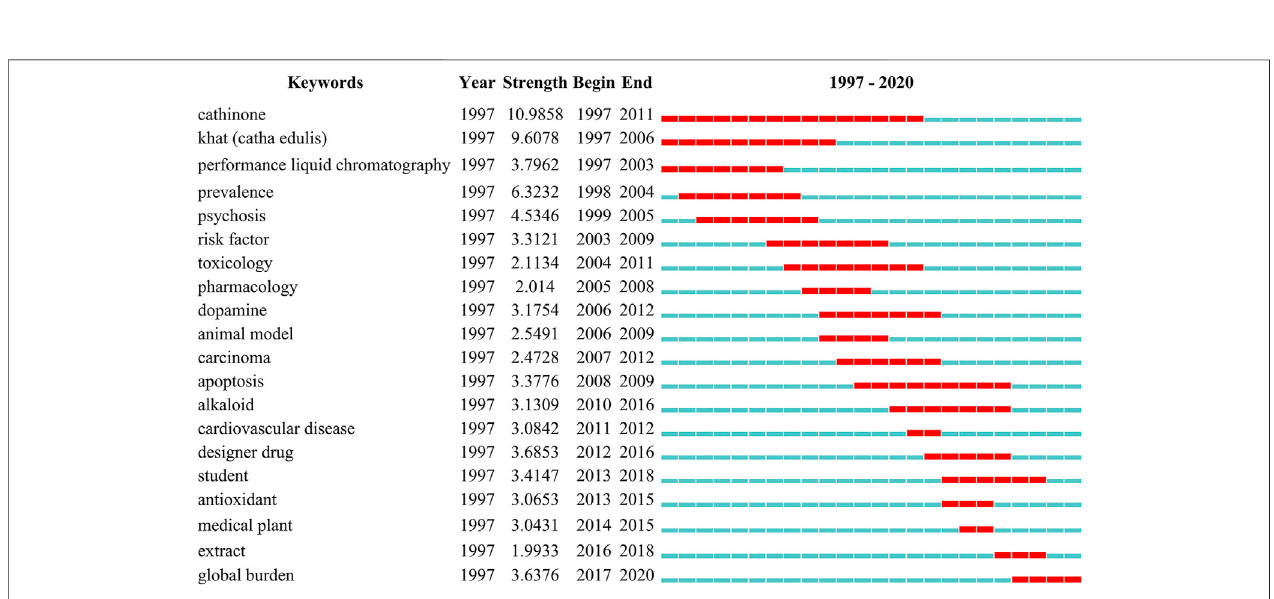
FIGURE5| Co-citedreferencestimelinemapof Cathaedulis .Nodesonthemaprepresentreferenceddocuments.Thesizeofnodesrepresentsthefrequenciesof cited references, and the location re fl ects the present time. And years are arranged horizontally at the top. The clusters are performed based on the themes of co-cited references and the label of each cluster is shown at the end of the timeline.